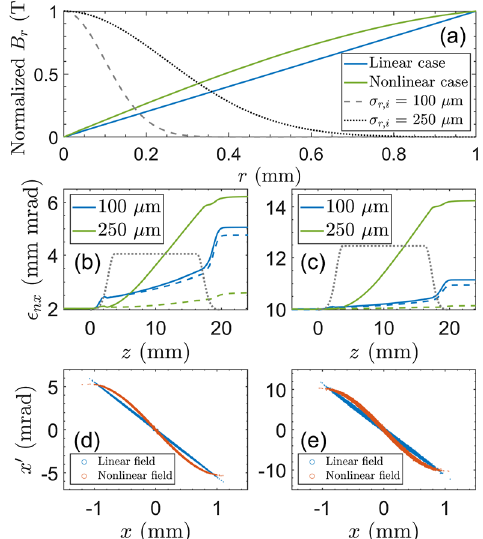
FIG. 10. (a) Focusing fields generated by the discharge current. (b – c) Evolutions of the emittance along the APL. Dashed lines indicate the cases with linear focusing field only whereas the solid lines represent the cases with nonlinear field. (d – e) Horizontal phase spaces right after the APL with the initial beam size of 250 μ m. The initial emittances are (b,d) 2 mm mrad and (c,e) 10 mm